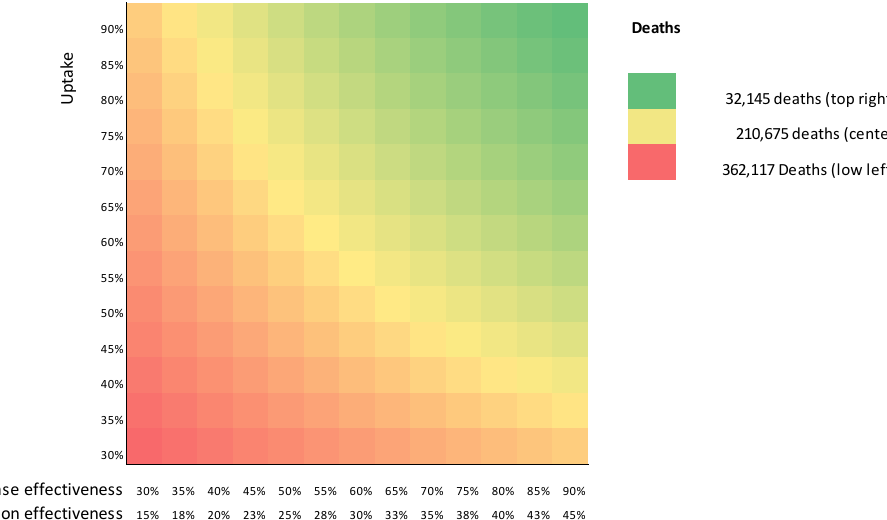
Figure 7. Heatmap of the number of COVID ‐ 19 deaths occurring after vaccination starts.